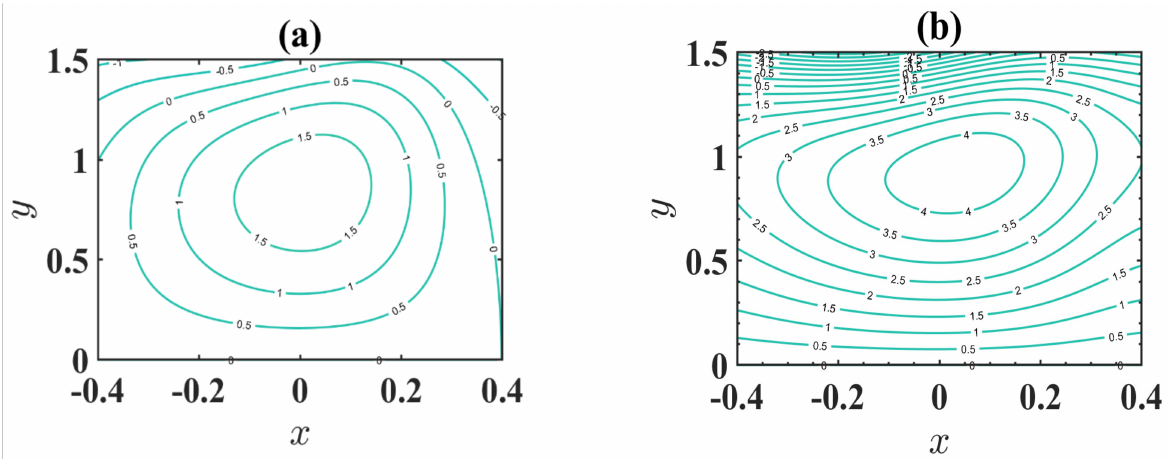
Figure 8. Streamlines for ( a ) m e = 1 and ( b ) m e = 3.